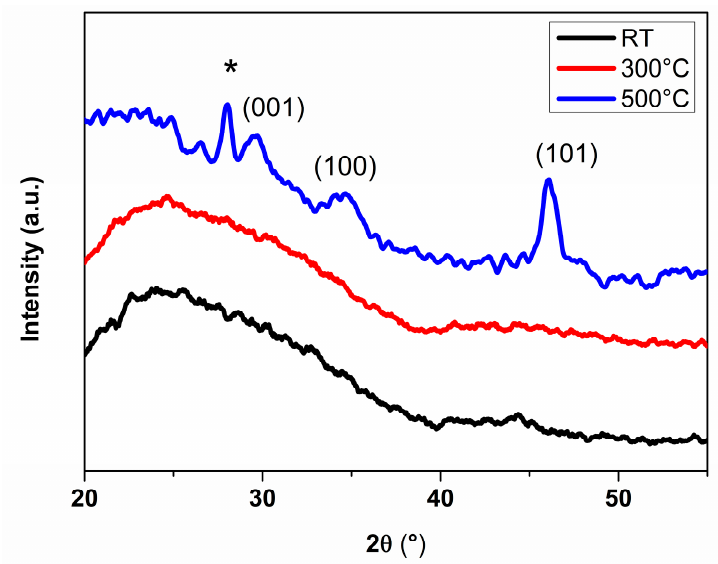
Figure 2. XRD spectra of the films deposited at different substrate temperatures from a target with a Cr-B molar ratio of 1:4. The assigned peaks refer to CrB 2 while the asterisk indicates a peak assigned to B 2 O 3 .